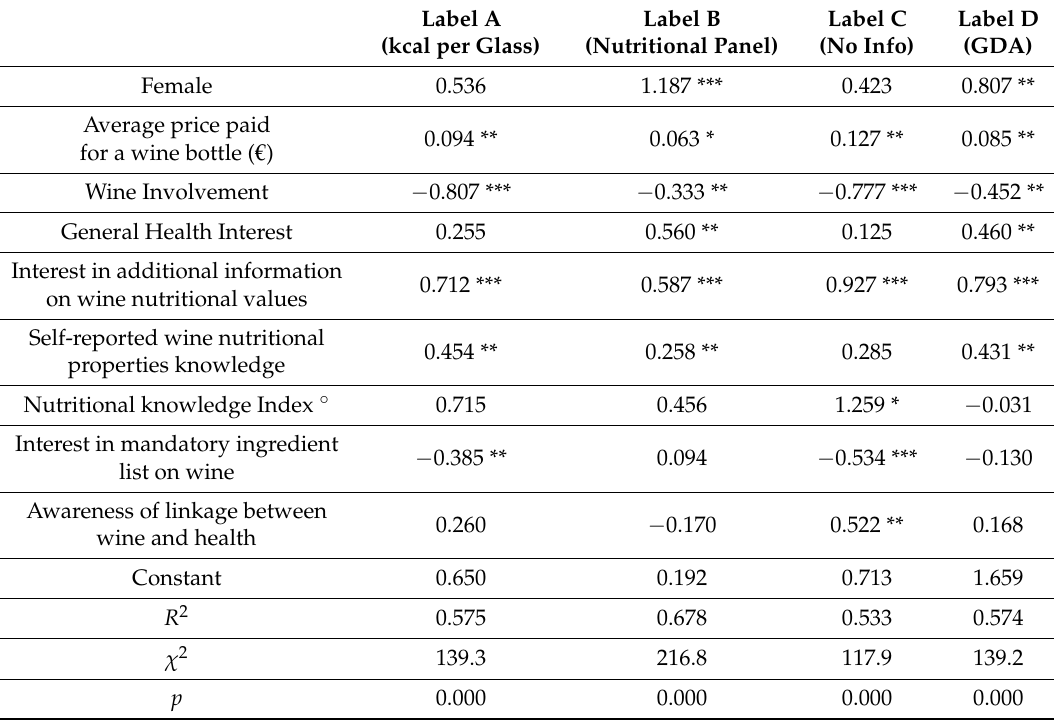
Table 5. Seemingly unrelated regression (SUR) selected coefficient estimates explaining respondents’ WTP for wine nutritional